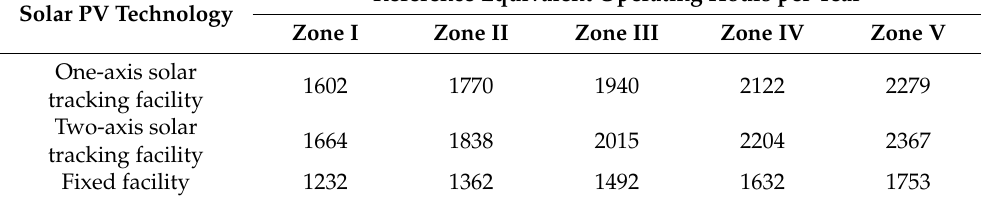
Table 8. Reference equivalent operating hours for PV power plants set by RDL 14/2010. Source: self-elaboration based on [84].